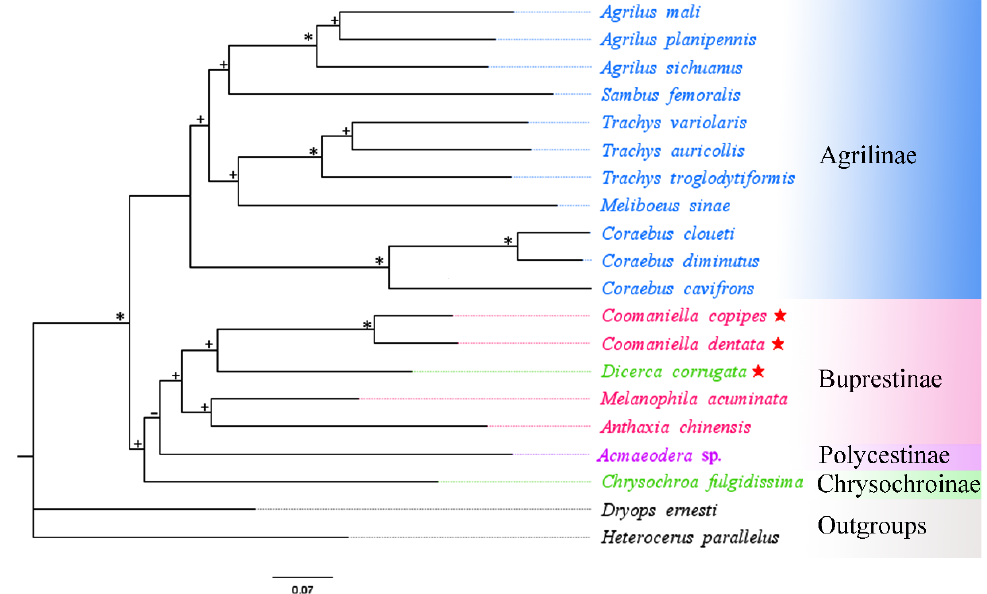
Figure 7. Phylogenetic relationships of 18 selected buprestid species using ML analyses based on 13 PCGs of mitogenomes. The symbols on the branches show bootstrap (ML tree). * ML bootstrap = 100; + ML bootstrap ≥ 50; − ML bootstrap < 50. Red star: means species which are newly sequenced in this study.